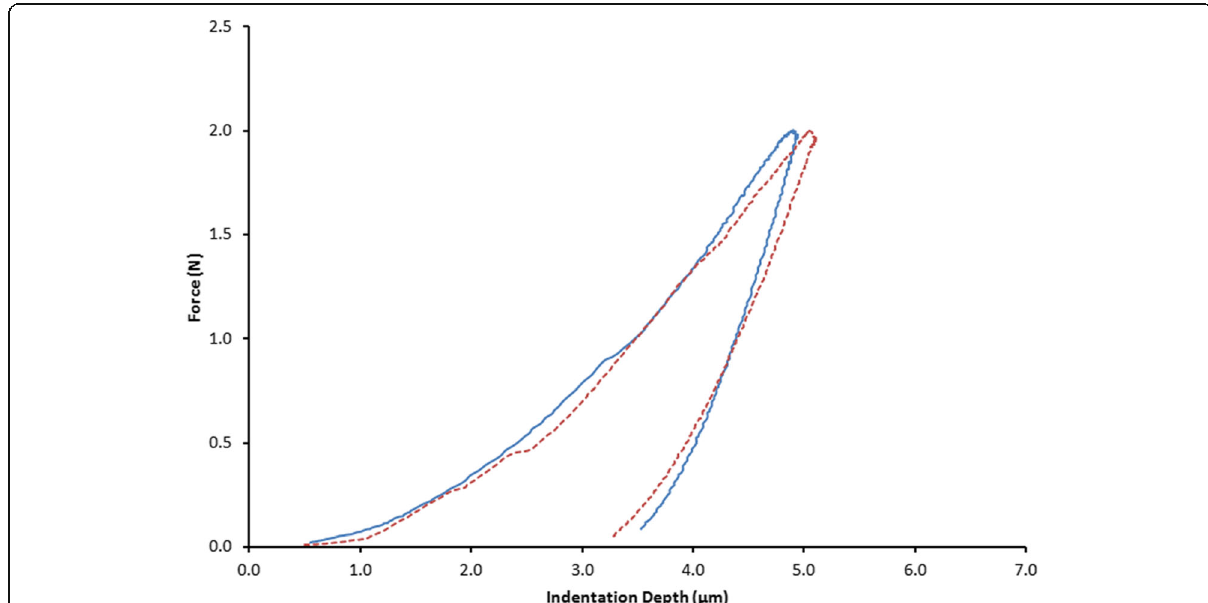
Fig. 2 Representative force-indentation depth curves. The shallower indentation depth (continuous line) indicates higher hardness while the steeper unloading curve shows increased indentation modulus of elasticity (continuous